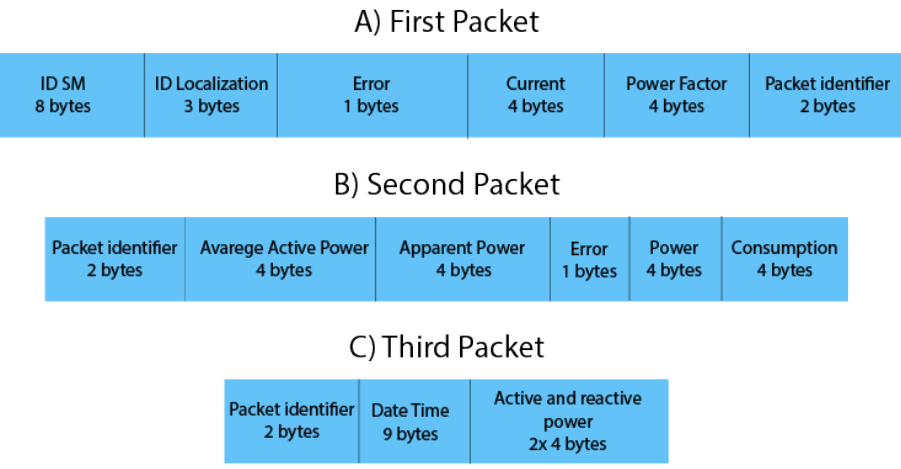
Figure 6. Packages of the SMs with size of 21